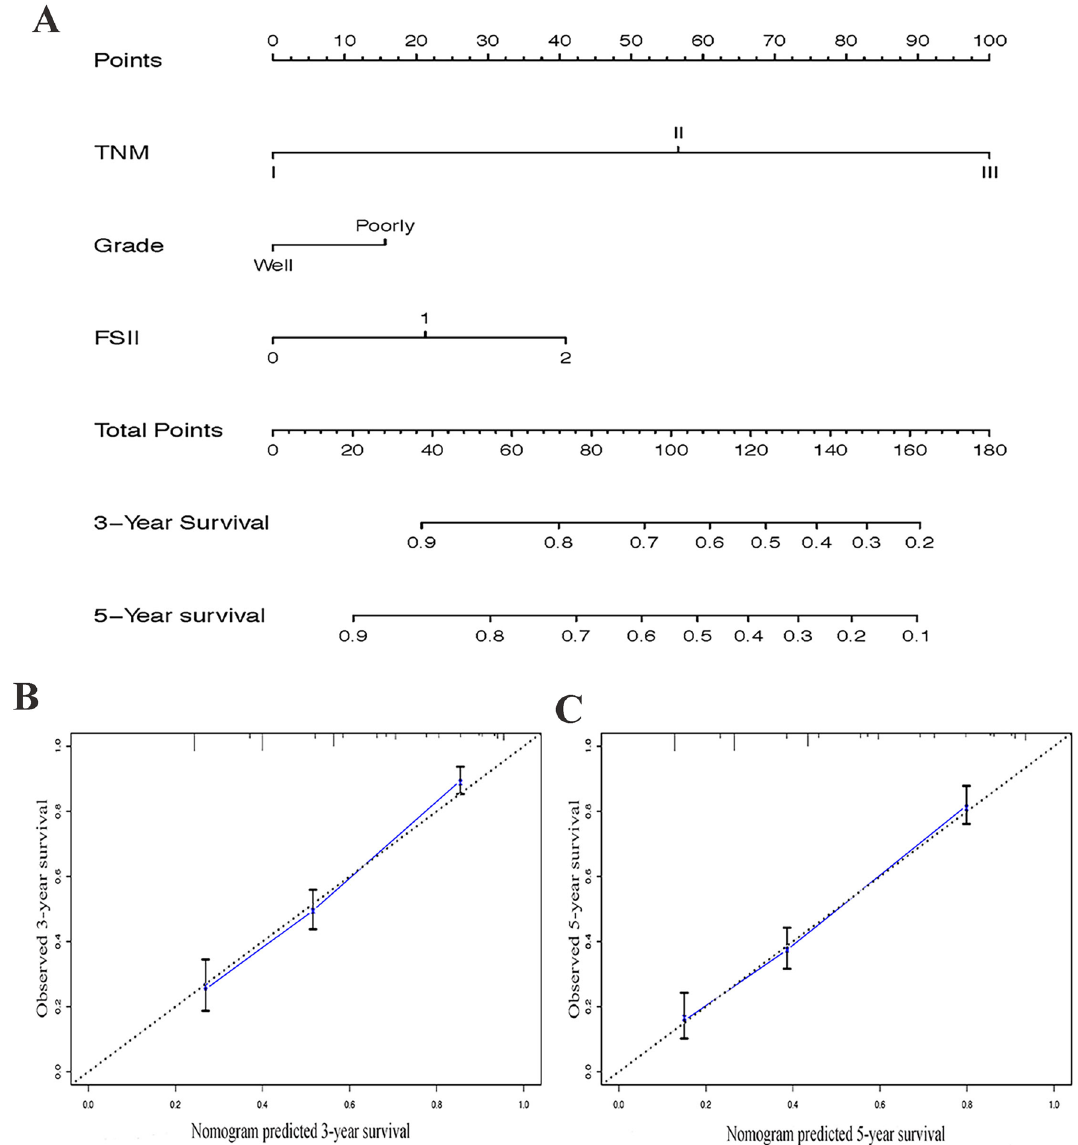
Figure 4. Nomogram for predicting 3- and 5-year OS of GC patients after surgery. ( A ) Nomogram for predicting 3- and 5-year OS of GC patients after surgery. Calibration plot of the nomogram for ( B ) 3-year and ( C ) 5-year survival. The dashed line represents the performance of an ideal nomogram. The blue line indicates the performance of the proposed nomogram. Blue circles are sub-cohorts of the data set; X is the bootstrapped corrected estimate of nomogram with 200 resamples. Vertical bars represent 95% CI. It seems that the nomogram predicts accurately 3- and 5-year